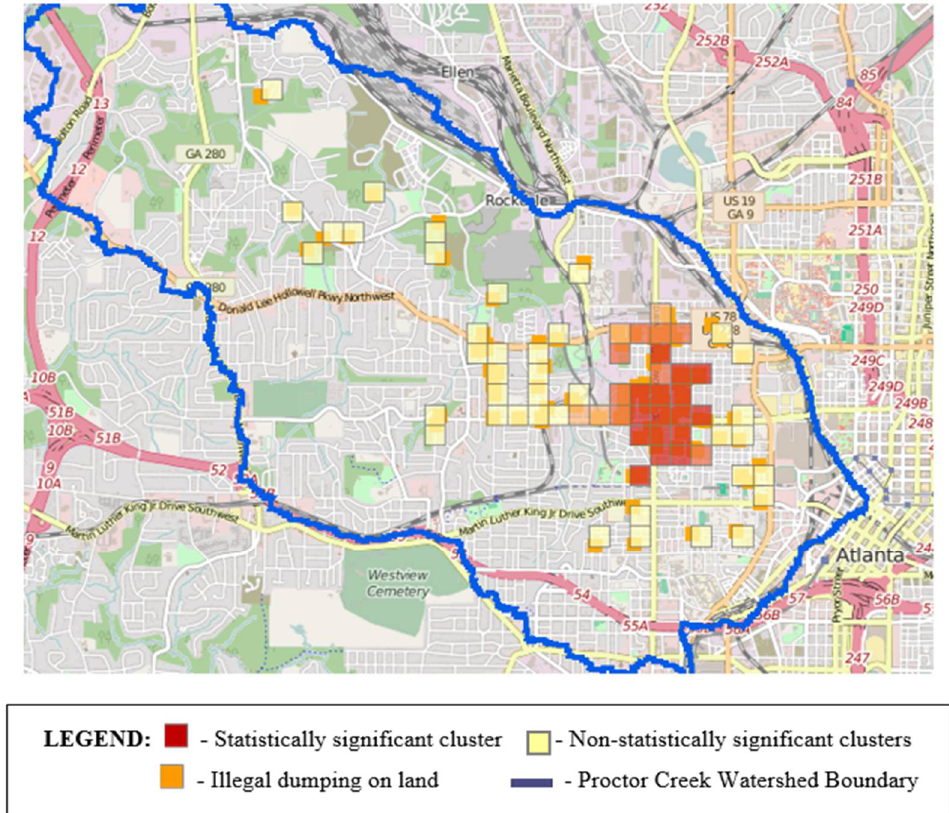
Figure 3. Statistically significant clustering of areas with illegal dumping mapped by community researchers in the Proctor Creek Watershed.